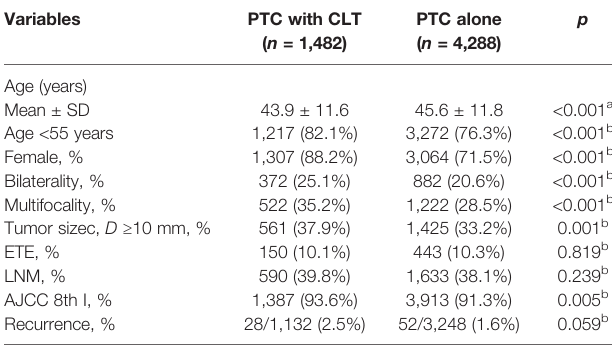
TABLE 1 | Clinicopathologic features of PTC patients with and without